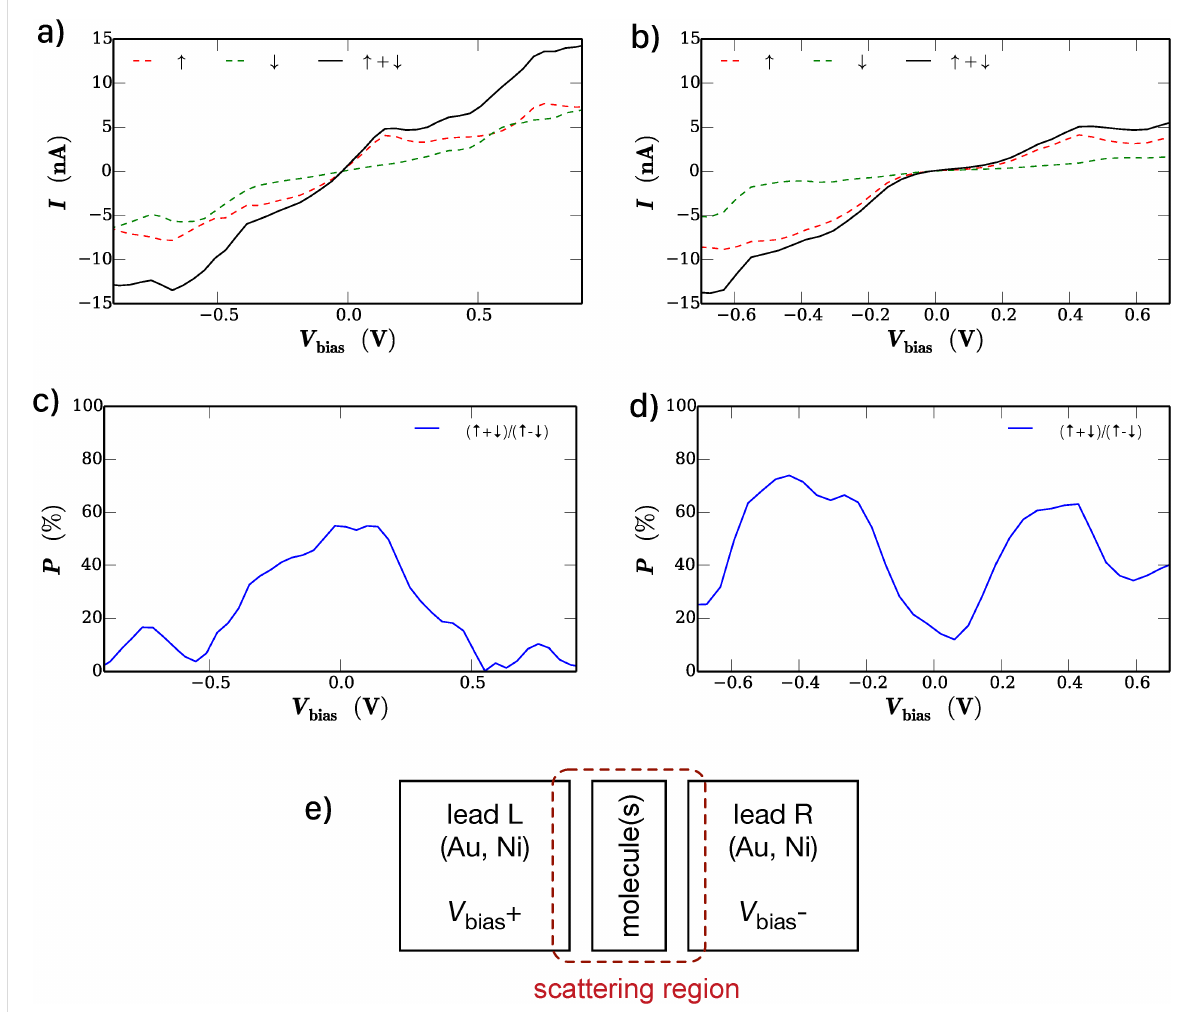
Figure 2: I – V curves calculated within the DFT-NEGF method for the sandwich structure a) CoPc/CoPc and b) F 16 CoPc/MnPc. c), d) Spin polariza- tion of the current as a function of the bias voltage. e) Schematic drawing of the used device configuration for the DFT-NEGF transport calculations.